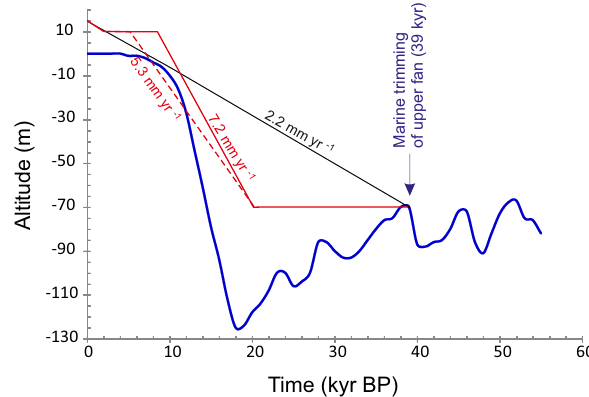
Figure 11. The plot discusses the required uplift rate to elevate the marine cliff and bench of the upper fan from its elevation at gene- sis (39kyrBP) to its present elevation ( + 14m). The simplified sea- level curve (after Siddall et al., 2003) is illustrated by the thick blue line. The black line represents a constant uplift rate of 2.2mmyr − 1 (established in this study). The dashed red line represents a mini- mum uplift rate for Domata of ∼ 5 . 3mmyr − 1 tailored to empirical data (Tiberti et al., 2014; Mouslopoulou et al., 2015b). The solid red line represents the uplift rate required for the fan system to escape marine inundation and destruction (see text for